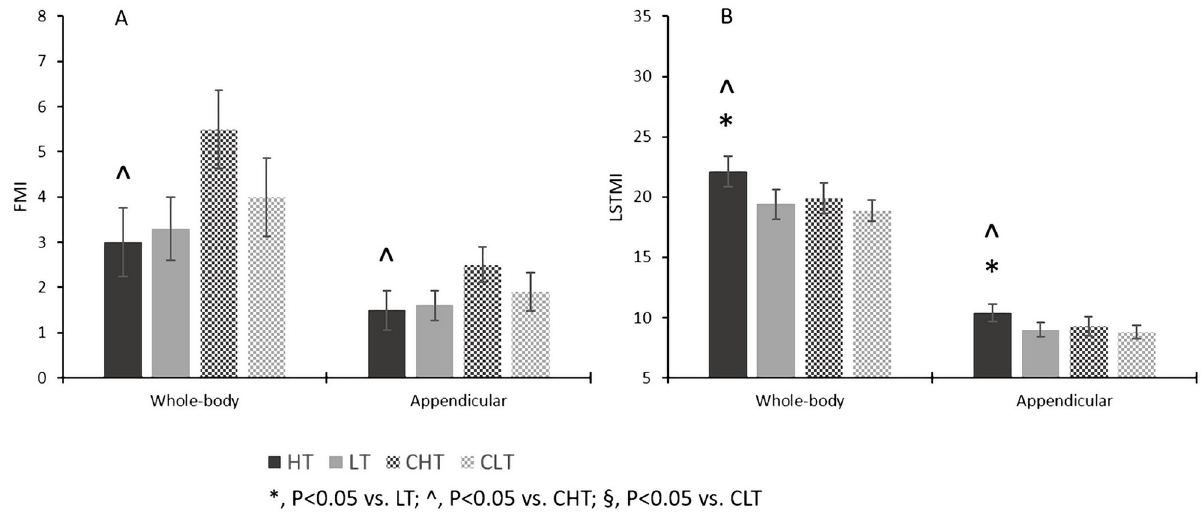
Fig 3. Whole-body and Appendicular Fat Mass Index (FMI, Panel A) and Lean Soft Tissue Mass Index (LSTMI, Panel B) in CF participants at higher (HT) and lower (LT) amounts of training, and in their age-matched and BMI-matched controls (CHT, CLT).